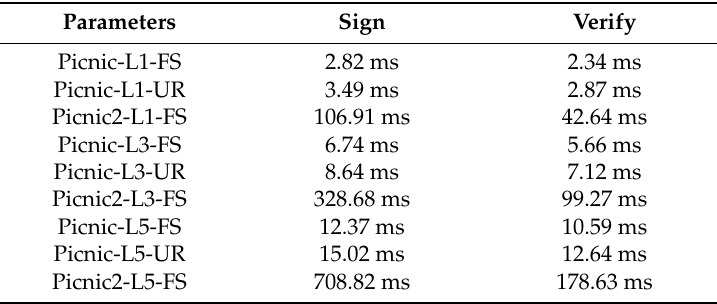
Table 5. Performance of picnic (C implementation) [22].